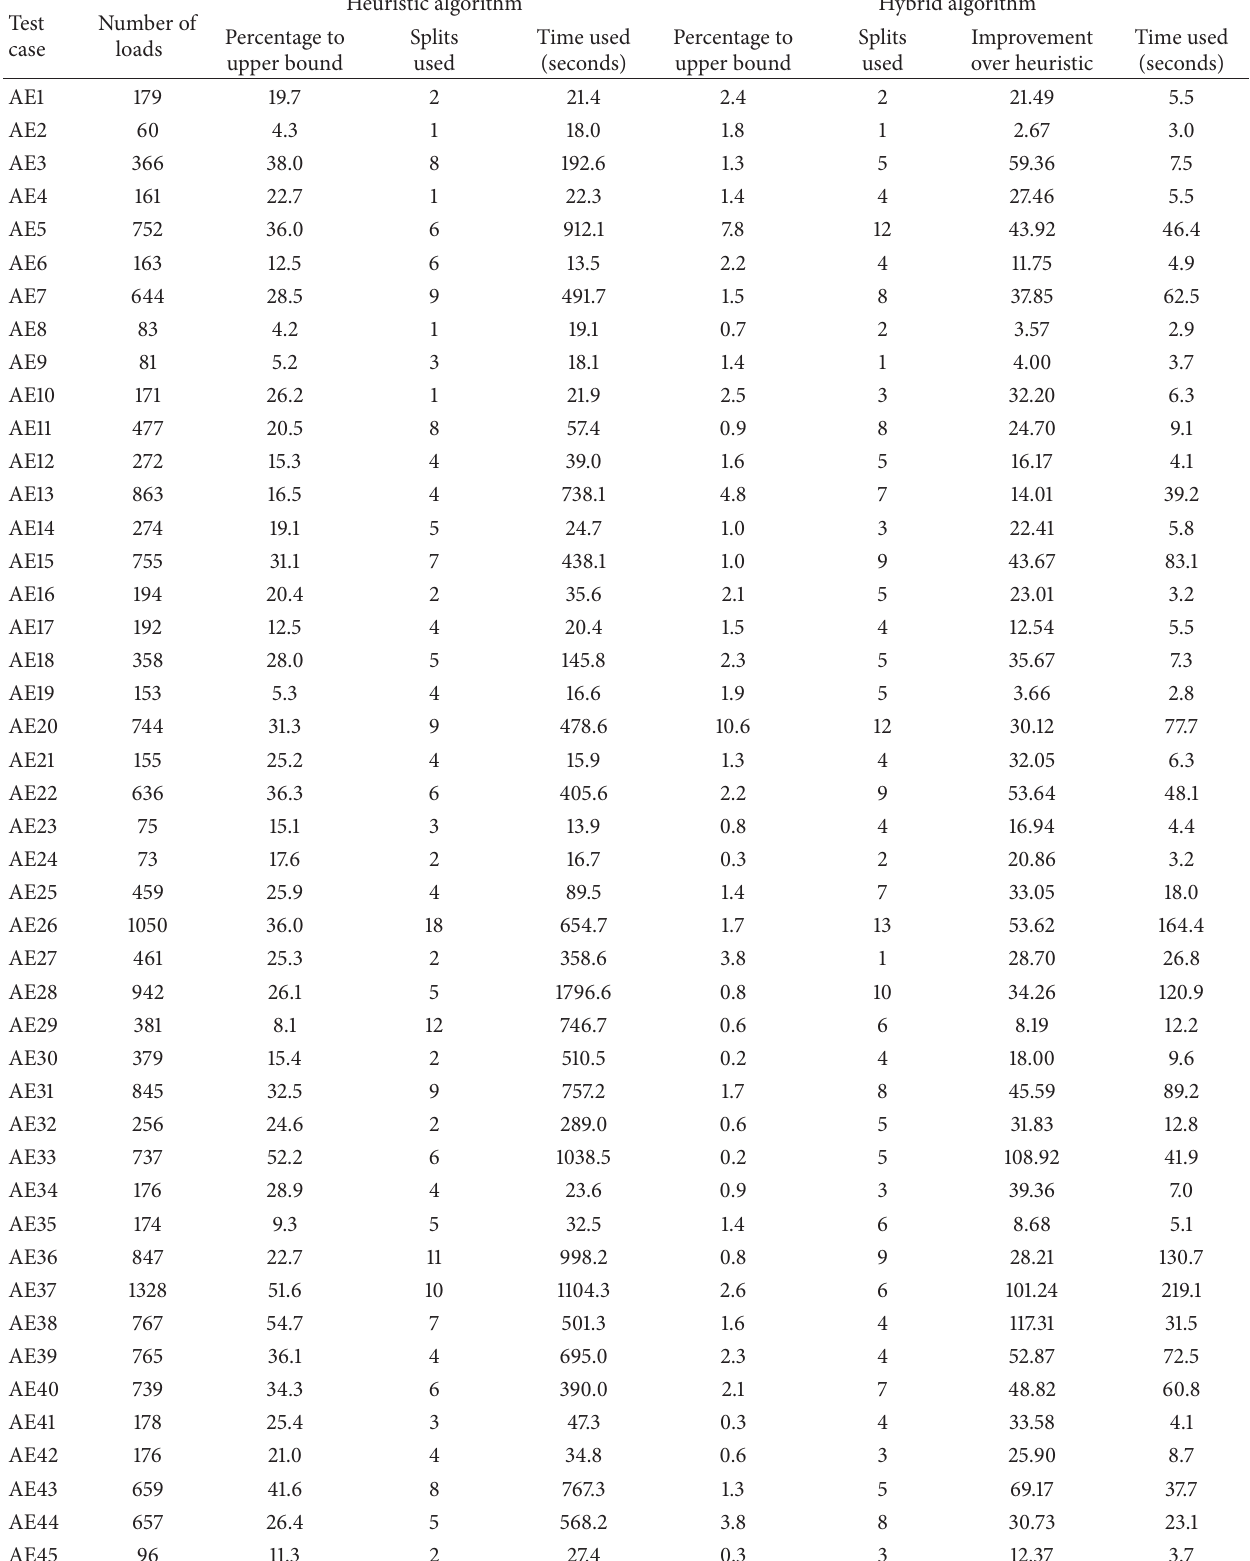
Table 6: Result of test cases